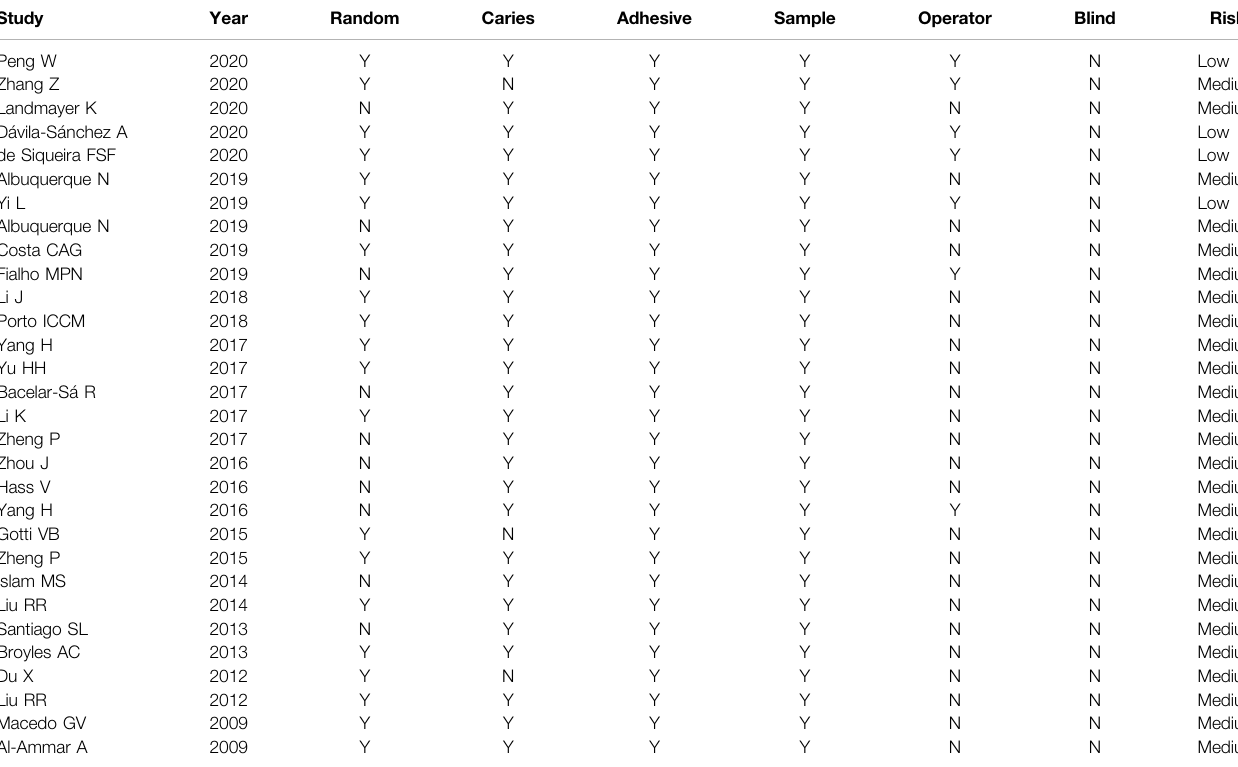
TABLE 2 | Risk of bias of the studies considering aspects reported in the Materials and Methods